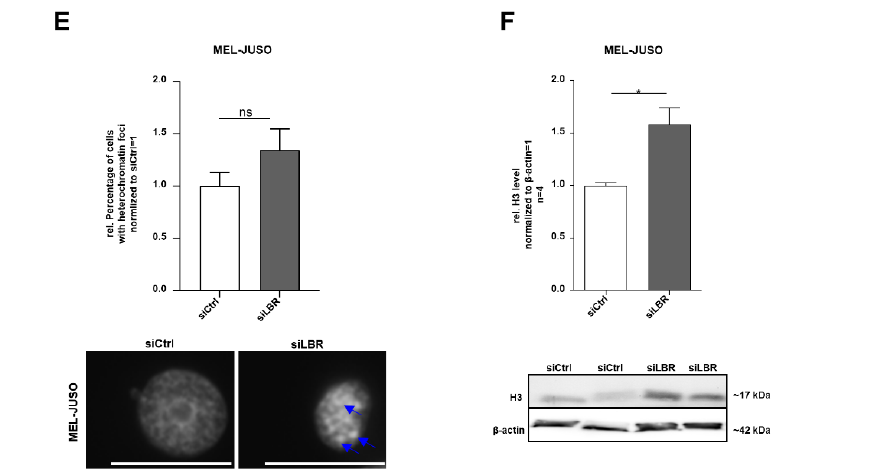
Figure 5. ( A ) RNA sequencing analysis of LBR expression in different WM cell lines compared to NHEMs (one-way ANOVA and subsequent Tukey’s multiple comparison test). ( B ) RNA sequenc- ing analysis of LBR expression in the primary melanoma compared to melanocytic nevi (one-way ANOVA and subsequent Tukey’s multiple comparison test). ( C ) Western blot analysis of LBR protein expression in NHEMs and various melanoma cell lines (Student’s t -test). ( D ) Immunofluorescence staining of LBR expression in MEL-JUSO transfected 72 h with siLBR and siCtrl, respectively. Representative examples of LBR expression (red) in the cell nucleus stained with DAPI (blue). Scale bars equal 20 µm. ( E ) The melanoma cell line MEL-JUSO was transfected for 72 h with siLBR and siCtrl, respectively. Chromatin condensation (DAPI) was analysed and quantified (Student’s t -test). Enlarged images show representative chromatin foci marked with blue arrows. Scale bars equal 20 µm. ( F ) Western blot analysis of the H3 level following 72 h treatment of siLBR and siCtrl, respec- tively, in MEL- JUSO using β -actin as a housekeeper (Student’s t -test). Bars represent the means ± SEM (* = p ≤ 0.05 , ns = not significant).